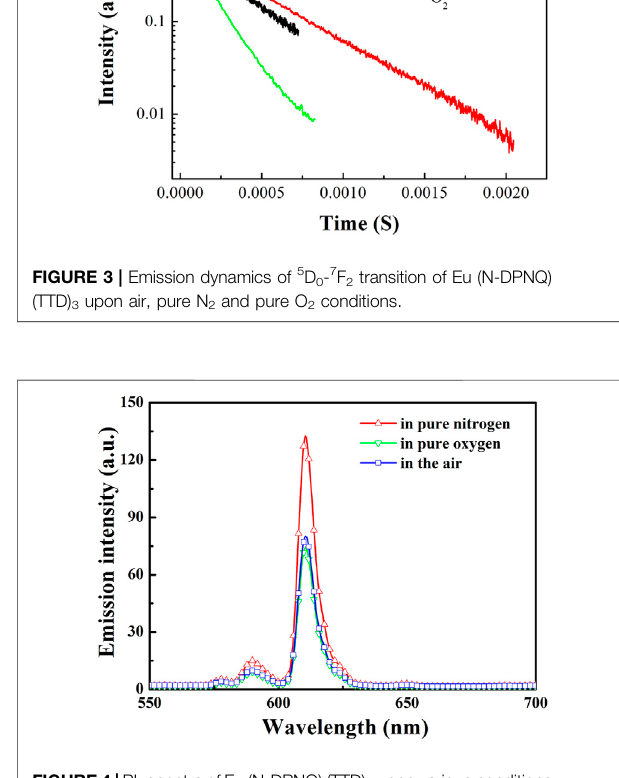
Eu(N-DPNQ)(TTD) 3 showed typical photoluminescence (PL) peaks of Eu(III) with fi ve bands peaking at 578, 590, 610, 649, and 699 nm, which correspond to 5 D 0 → 7 F n ones ( n (cid:2) 0 – 4), respectively.